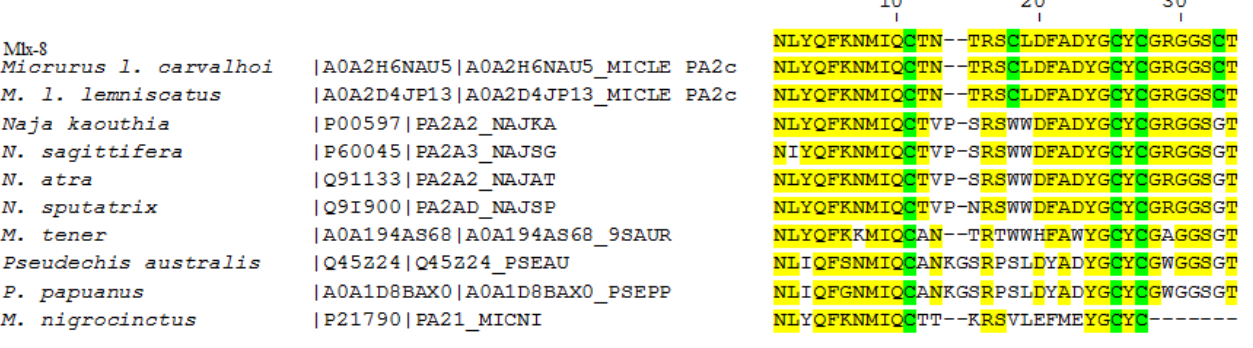
Figure 3. Amino acid multiple sequence alignment. The Mlx-8 toxin obtained from Micrurus lemniscatus venom was aligned with other PLA lemniscatus carvalhoi [9] and from Lemnitoxin from Micrurus lemniscatus [31]. In addition, this sequence was analyzed against the public protein data bank to check for similarities with known proteins. Besides that, matches were identified with toxins from Naja Kaouthia , N. sagittifera , N. atra , N. sputatrix , M. tener, Pseudechis australis, P. papuanus and M. nigrocintus